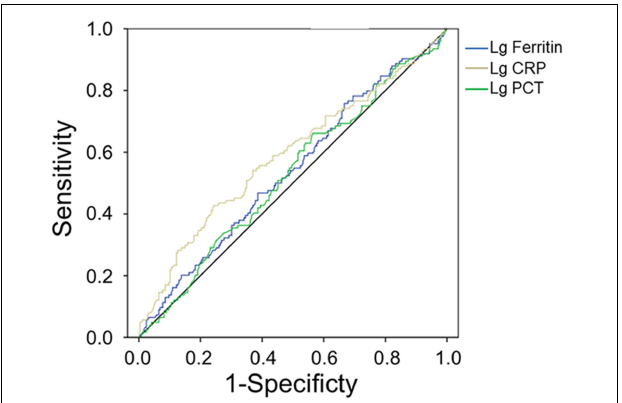
FIGURE 2 | Receiver operating characteristics curve showing the performance of serum ferritin as a predictor of bacterial co-infection. The AUC of serum ferritin = 0.540, the AUC of PCT = 0.527, and the AUC of CRP = 0.588, only p CRP < 0.01.